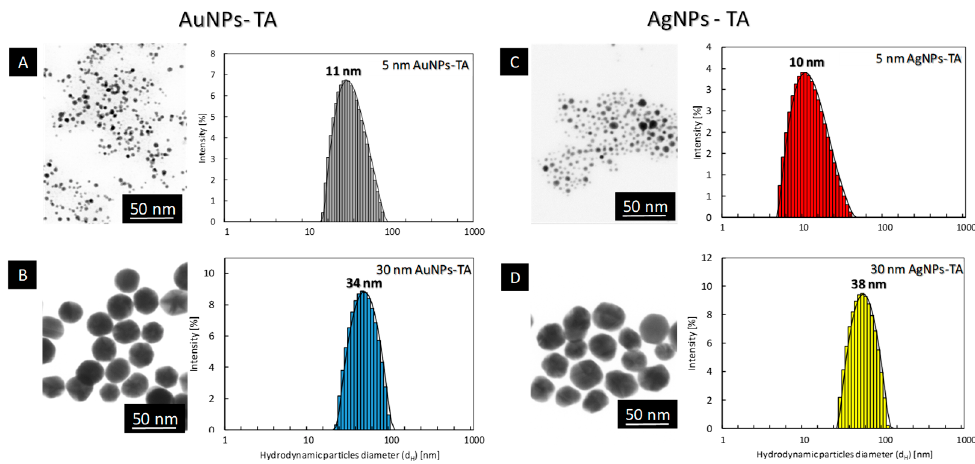
Figure 1. STEM images and DLS size distribution histograms of polyphenol-conjugated metallic nanoparticles: 5 nm AuNPs-TA ( A ); 30 nm AuNPs-TA ( B ); 5 nm AgNPs-TA ( C ); 30 nm AgNPs-TA ( D ).